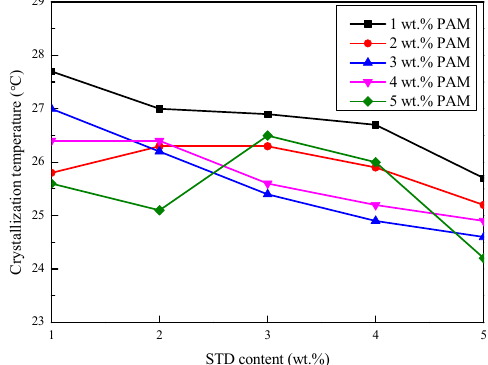
Figure 8. Effect of PAM and STD content on the crystallization temperature of the Na 2 SO 4 ·10H 2 O composites.